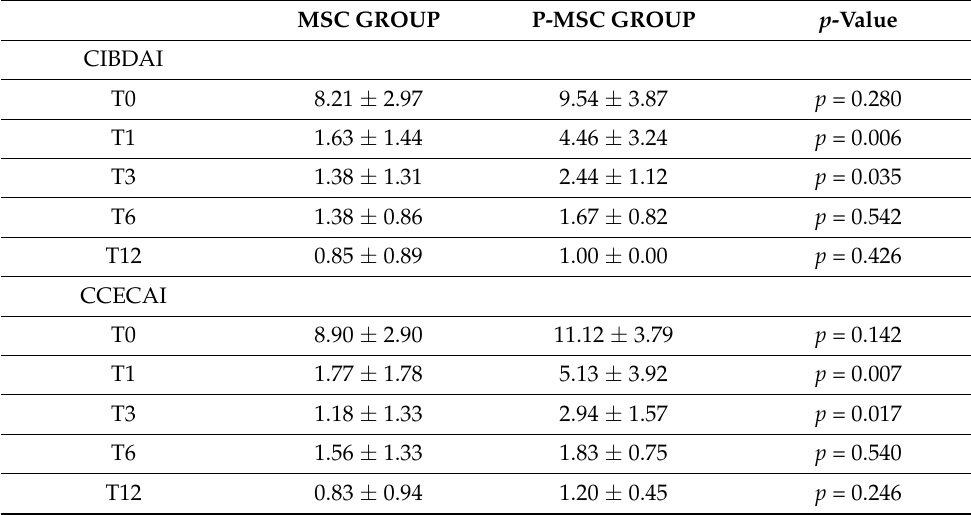
Table 2. Mean and standard deviation of the clinical indices CIBDAI and CCECAI, albumin, cobalamin and the prednisone